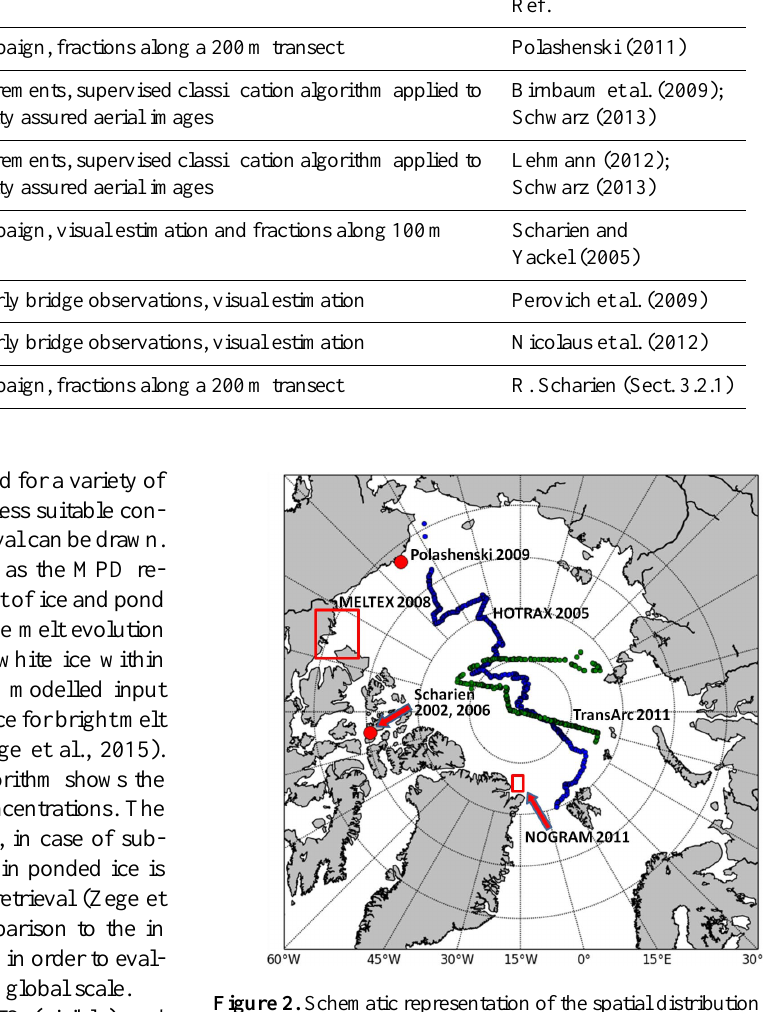
Figure 2. Schematic representation of the spatial distribution of the validation data. Red dots show the location of in situ field mea- surements; tracks – ship cruises, rectangles – approximate area of airborne measurements. The data includes FYI and